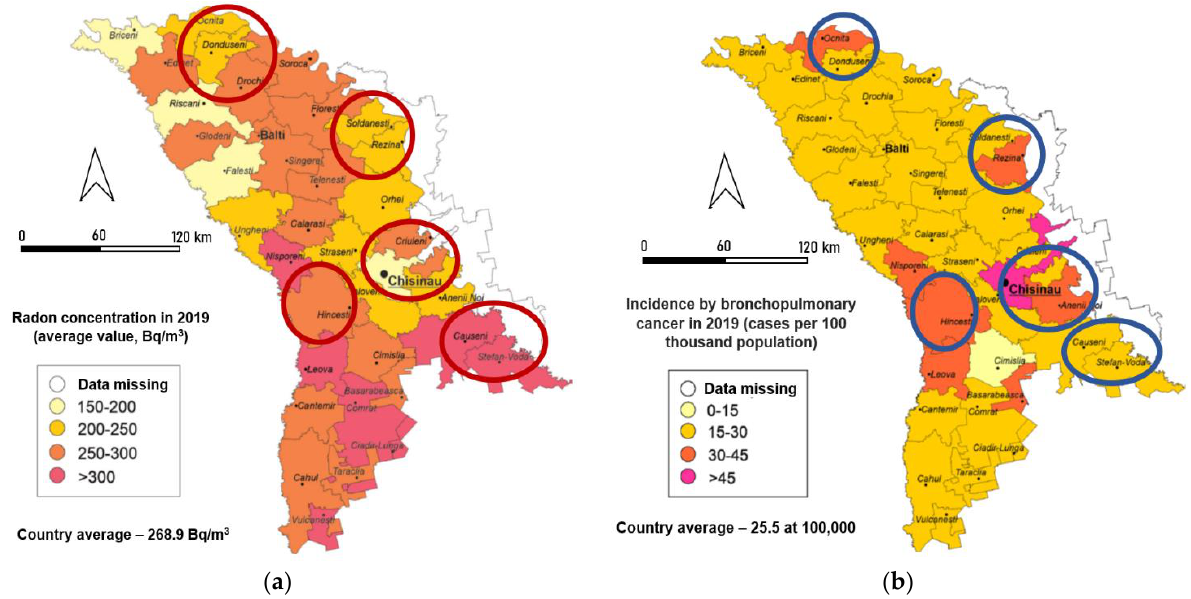
Figure 9. Radon concentration (Bq/m 3 ) ( a ) and incidence by bronchopulmonary cancer (cases per 100 thousand population) ( b ).